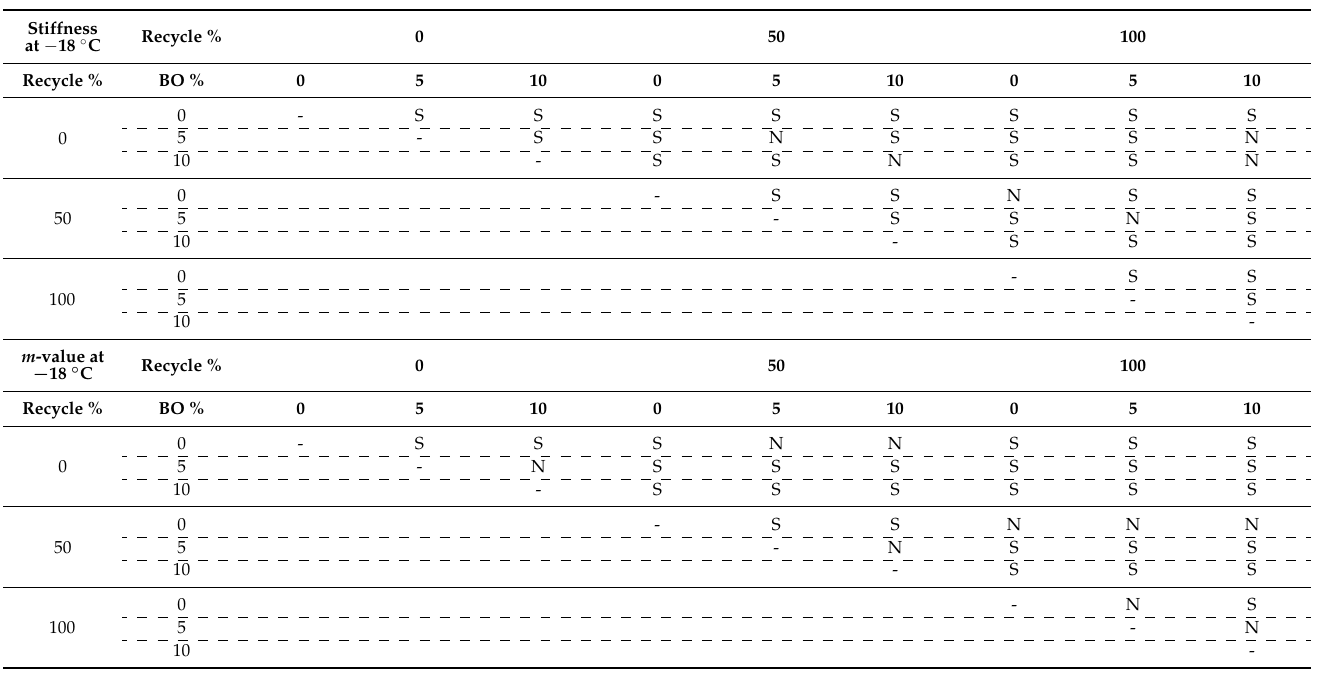
Table 8. Statistical analysis results of the stiffness and m- value for RTFO + PAV as a function of aged binder contents and the addition of base oil at − 18 ◦ C ( α = 0.05).